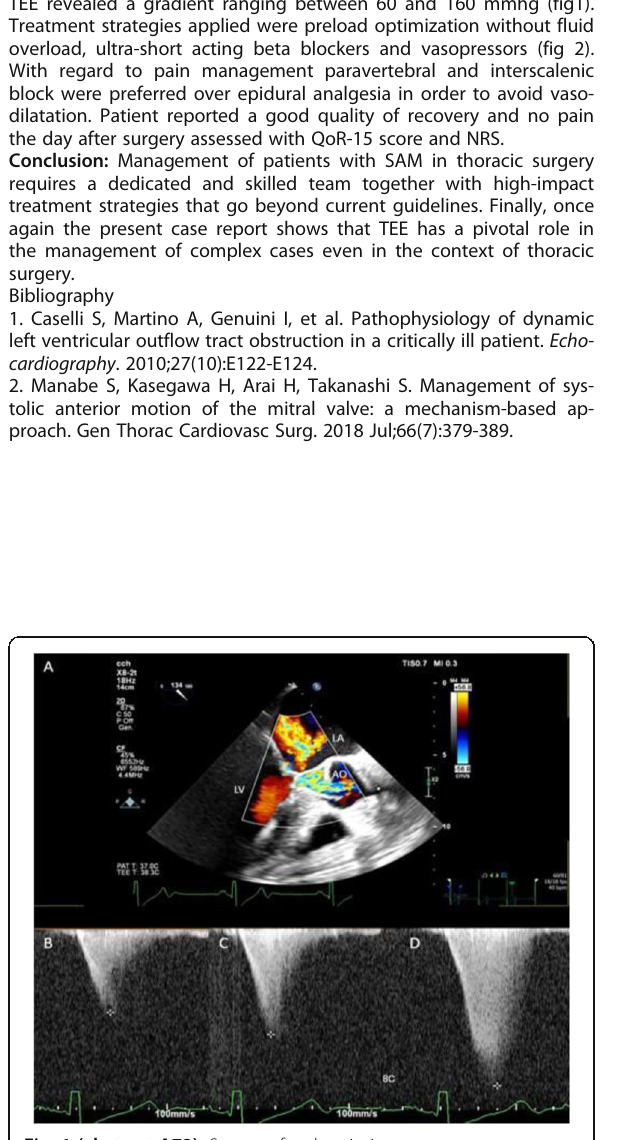
Fig. 1 (abstract A72). See text for